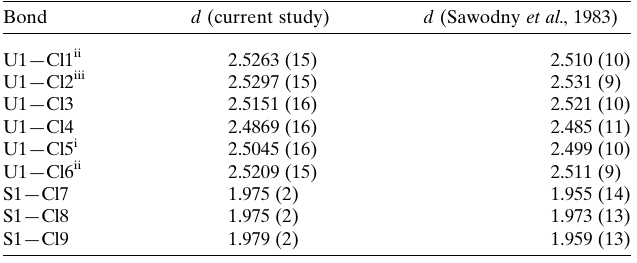
Table 1 Selected interatomic distances d (A˚ ) for (SCl 3 )[UCl 6 ] from the current and the previous refinement.